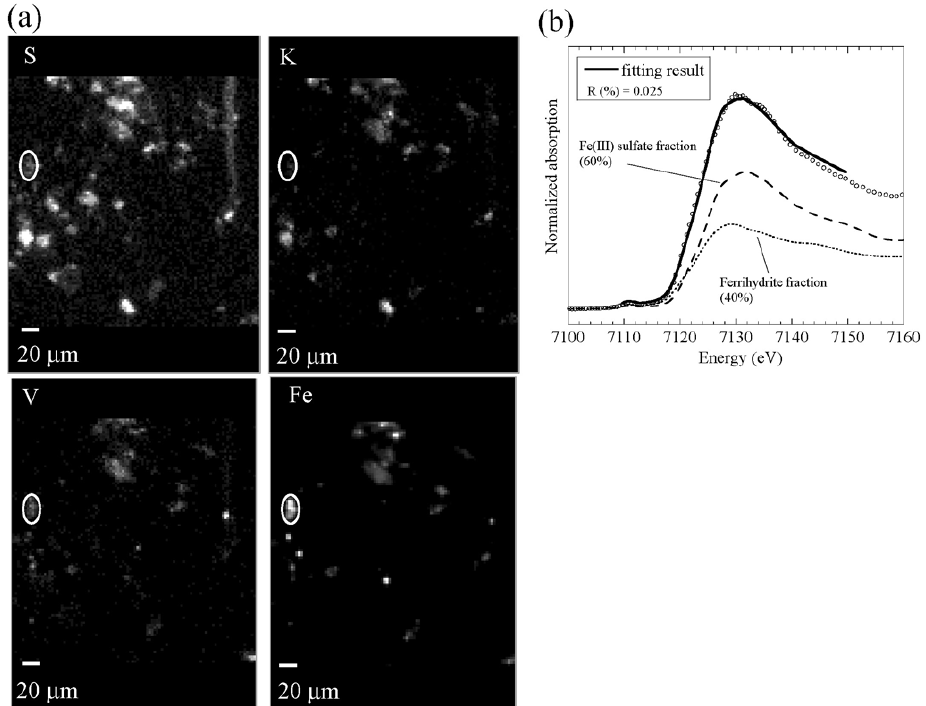
Fig. 8. (a) Micro-XRF mapping of S, K, V, and Fe for aerosol samples dispersed in a Kapton filter for the sample collected in July and (b) Fe K-edge XANES for the spot indicated with a circle in (a)